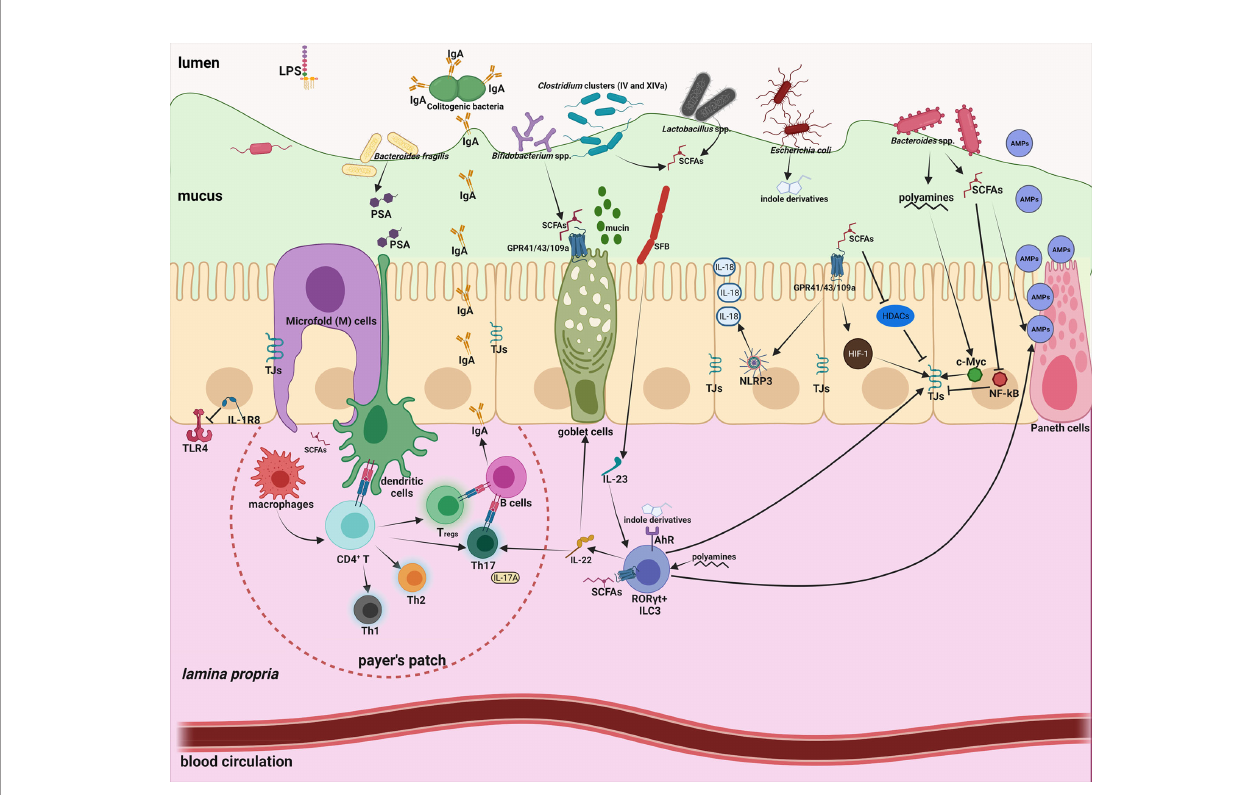
FIGURE 1 | Intestinal homeostasis is tightly controlled by gut microbiota through a large number of microbial metabolites/components. Intestinal mucus not only provides a habitat for bacterial colonization but also serves as a lubricant barrier to restrict most gut microbes in the outer layer. Microfold (M) cells above the Peyer ’ s patch are essential to transport microbiota-derived metabolites/components to maintain the homeostasis of the mucosal immune system. 1) The effects of short- chain-fatty-acids (SCFAs) are manifold, including enhanced mucus production; inhibition of nuclear factor- k B (NF- k B); activation of NLR-family-pyrin-domain- containing-3 (NLRP3) in fl ammasomes and subsequent production of interleukin-18 (IL-18); enhanced antimicrobial peptide (AMP) production; polarization of anti- in fl ammatory macrophages; increased Immunoglobulin A (IgA) secretion; reduced expression of T cell-activating molecules on antigen-presenting cells; and increased number and function of colonic regulatory T (T regs ) cells. 2) Polyamines can activate ROR g t+ group 3 innate lymphoid cells (ILC3) and induce production of IL-22, which promote mucus and AMP secretion, and ensure commensal compartmentalization from the intestinal epithelium. 3) Indole derivatives produced by gut commensals can stimulate Aryl-Hydrocarbon-Receptor (AhR) to activate ILC3 and fortify the epithelium barrier function. 4) Polysaccharide A (PSA) from Bacteroides fragilis is taken up by DCs, processed and presented to naive CD4 + T cells, inducing the expansion of FOXP3 + T reg cells. 5) Attachment of segmented fi lamentous bacteria (SFB) to the epithelium enhances differentiation and expansion of CD4 + Th17 cells. Foxp3 + Treg cells and Th17 cells localize in the Peyer ’ s patches, and induce B cell class-switch and IgA production, which in turn remodels microbiota. 6) Basolateral location of the LPS receptor TLR4 on IECs and expression of the anti-in fl ammatory IL-1R8 allow proper immune